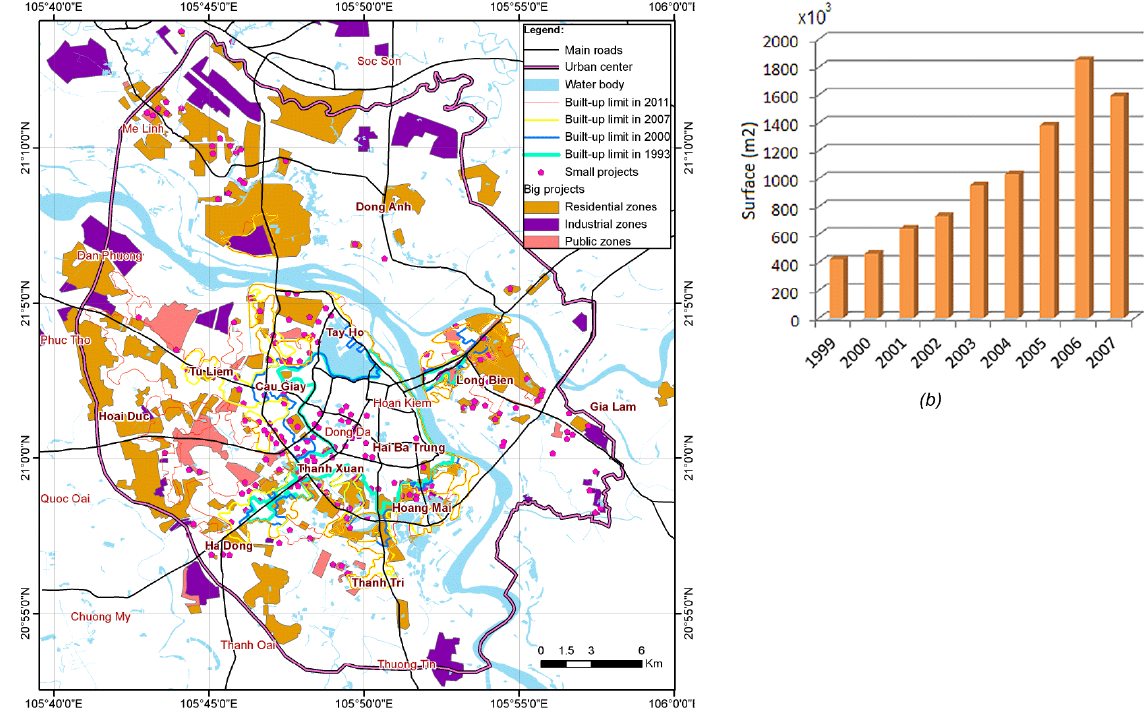
Fig. 10. (a) Location of new construction projects by public construction companies in urban region of Hanoi City, (after NARENCA, 2010) and evolution of built-up surfaces until 1993, 2000, 2007, and 2011 digitized from Landsat images. (b) Evolution of Hanoi housing surfaces constructed ( × 10 3 m 2 ) from 1999 to 2007, (after Hanoi Department of Construction,